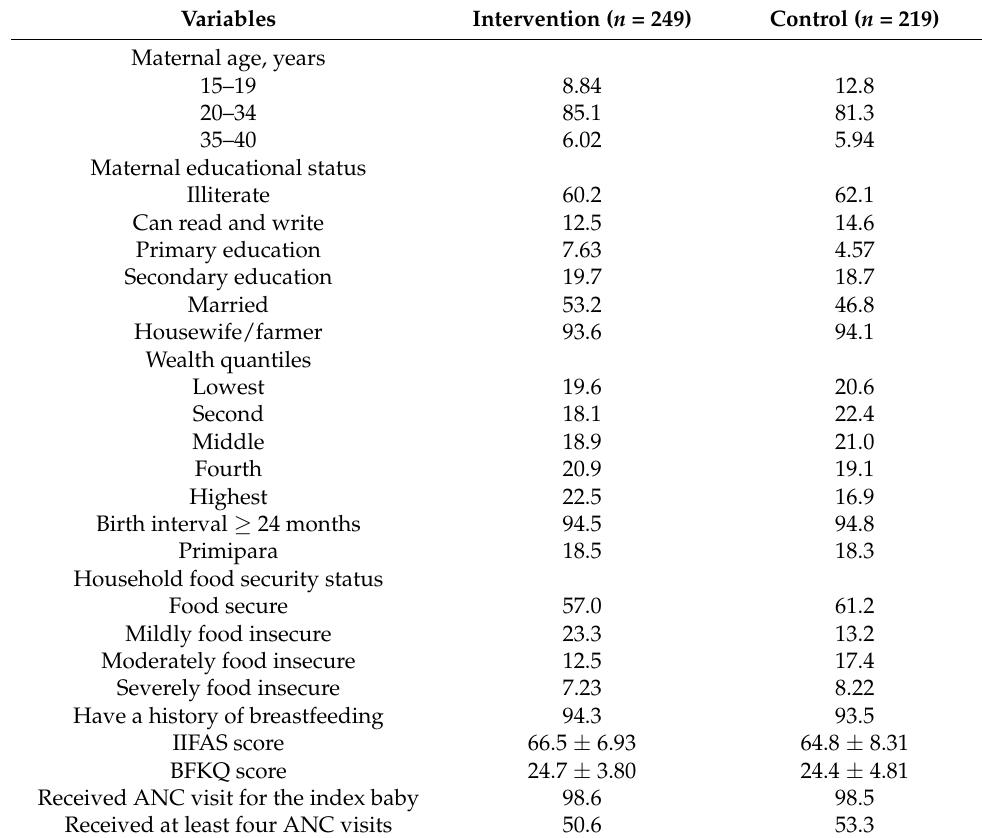
Table 1. Baseline characteristics of the study participants 1